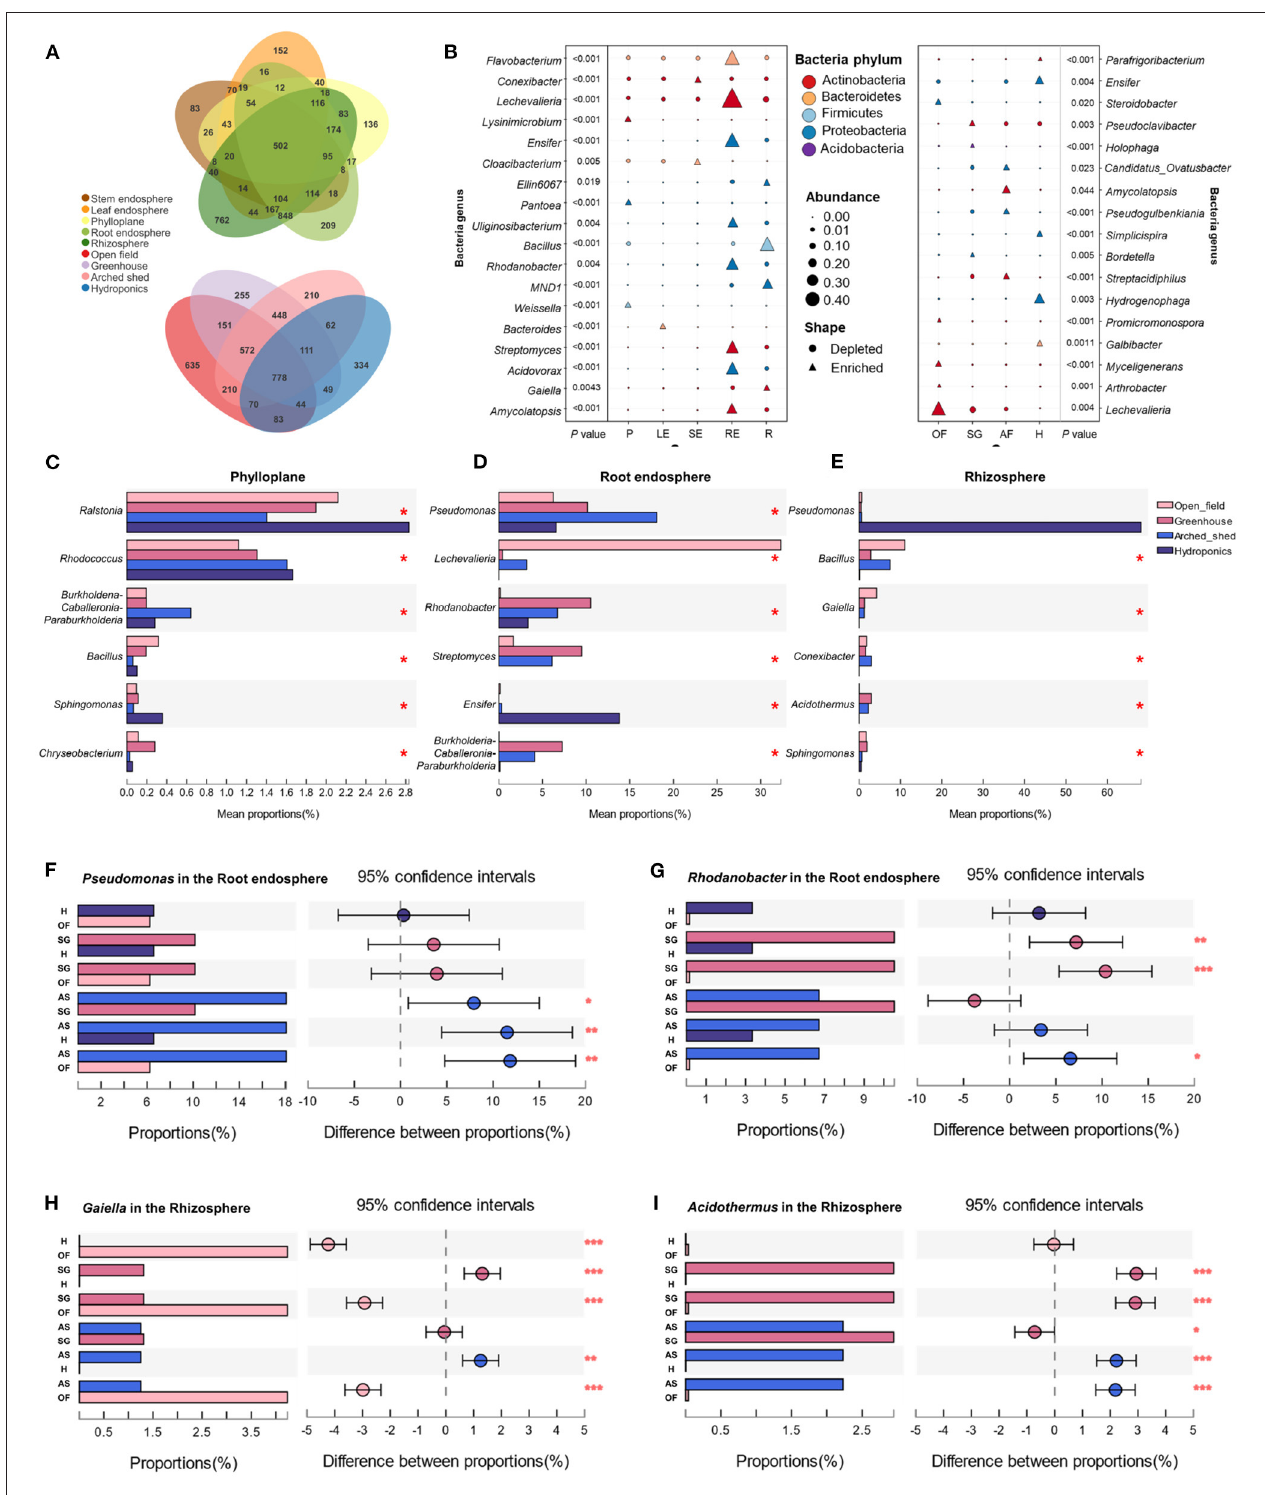
FIGURE 3 | Specific bacterial communities in different ecological compartments. (A) UpSet plot shows the OTU count of each group. (B) Indicator species in ecological compartments. The bacterial abundance at the genus level was analyzed. The shape of the point represents the enrichment or deletion of OTUs in the population, and the size of the point represents the abundance of OTUs. SE, stem endosphere; LE, leaf endosphere; P, phylloplane; RE, root endosphere; R, rhizosphere. Differences in bacterial genera in the phylloplane, (C) root endosphere, (D) ; and rhizosphere, (E) under growth conditions. Comparison and analysis of OTU abundances of Pseudomonas (F) and Rhodanobacter (G) in the root endosphere and Gaiella (H) and Acidothermus (I) in the rhizosphere among different growth conditions. OF, open field; SG, solar greenhouse; AS, arched shed; H, hydroponics. * P ≤ 0.05. ** P ≤ 0.01. *** P ≤ 0.001.